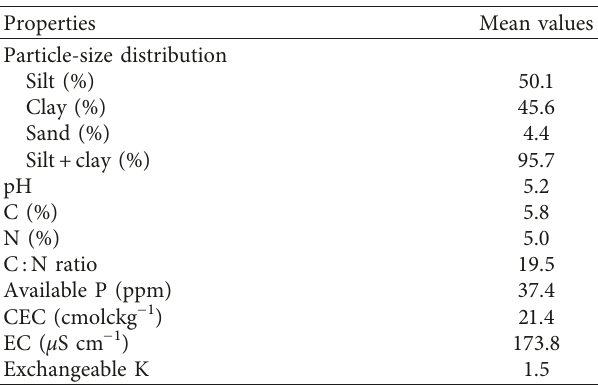
Table 2: Physicochemical properties of the soils used in the